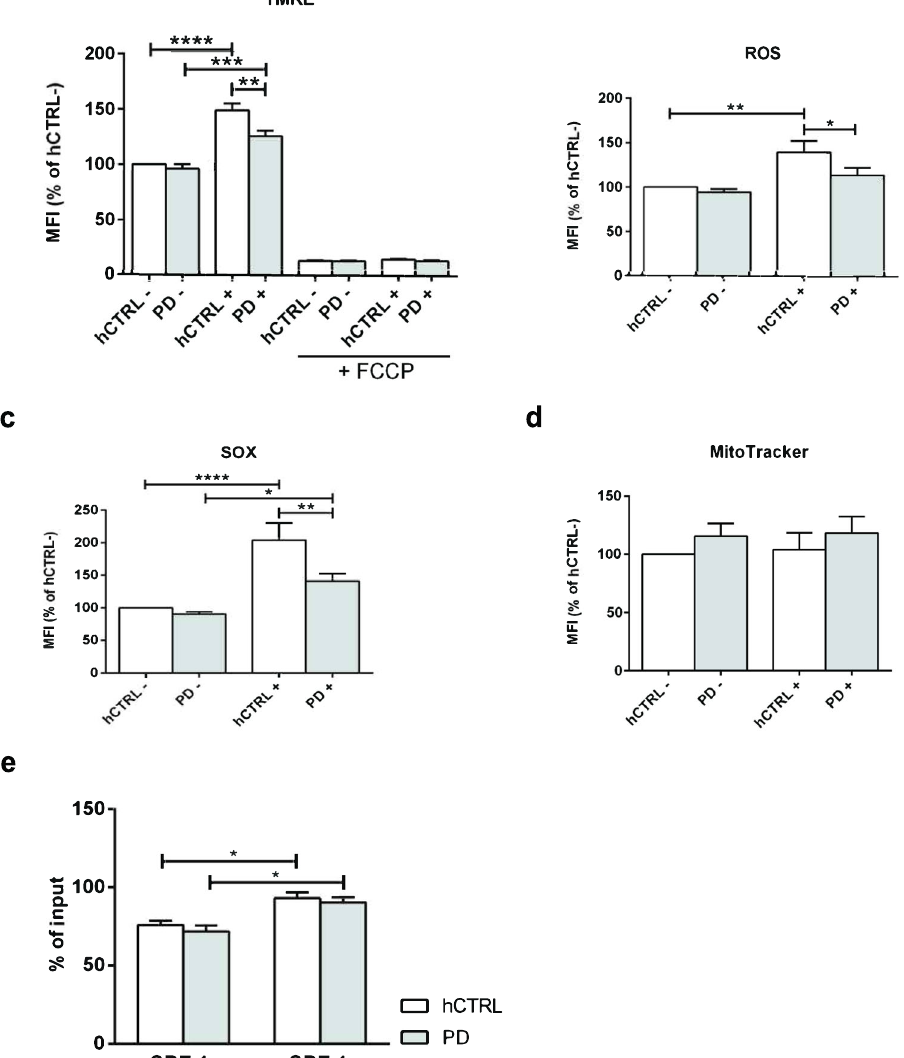
Fig. 4 Altered mitochondrial activity in PD cells and Coenzyme Q10 rescue. Eleven PD (CD3/CD28 non-activated and activated, PD − and PD + respectively) and 11 age/sex-matched healthy controls (CD3/CD28 non-activated and activated, hCTRL − and hCTRL + respectively) derived CD4 + T cells were cultured for 48 h, stained for viability and assayed accordingly. a Quanti fi cation of mitochondrial membrane potential (TMRE). The cells were stained with 50 nM TMRE for 20 min at 37 °C. The cells treated with 20 μ M FCCP for 10 min at 37 °C were used as a control. TMRE signal was analysed by fl ow cytometry. b Quanti fi cation of DCFDA signal representing total cellular ROS production. The cells were stained with 20 μ M DCFDA for 30 min at 37 °C and fl uorescence was analysed by fl ow cytometry. c Quanti fi cation of mitochondrial superoxide (SOX). The cells were stained with 5 μ M MitoSOX ™ Red for 10 min at 37 °C and the signal was obtained by fl ow cytometry. d Quanti fi cation of MitoTracker. The cells were stained with 50 nM MitoTracker ® Green FM for 30 min at 37 °C. The resulting fl uorescence signal was analysed by fl ow cytometry. The data were obtained from 11 independent experiments. a – d Within each experiment, cumulative median fl uorescence intensity data were expressed as a percentage of the hCTRL- group and shown as mean ± SEM. Statistical signi fi cance was assessed by using two-way ANOVA followed by Bonferroni ’ s multiple comparisons test. * p < 0.05, ** p < 0.01, *** p < 0.001, **** p < 0.0001. e Transwell migration of Coenzyme Q10 treated primary CD4 + T cells derived from three PD patients and three age/sex-matched healthy controls with or without SDF-1 α . The percentages of migrated cells to input cells for each group and condition are expressed as the mean percentage ± SEM. Statistical signi fi cance was assessed by using two-way ANOVA followed by Tukey ’ s multiple comparisons test. * p <